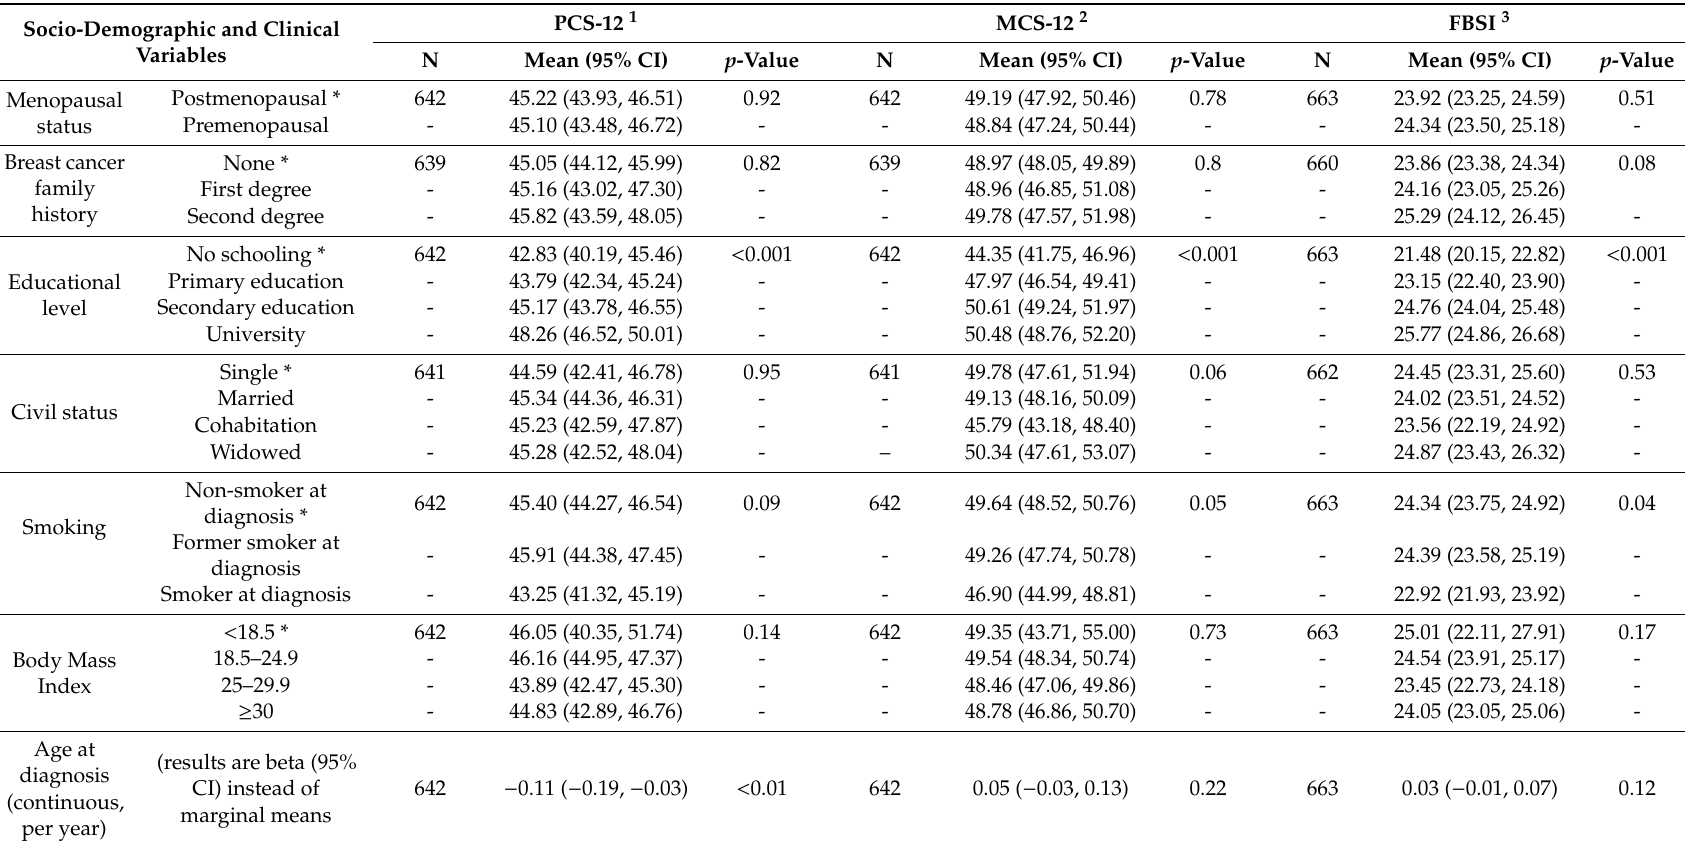
Table 1. Marginal means of health-related quality of life scores according to socio-demographic and clinical